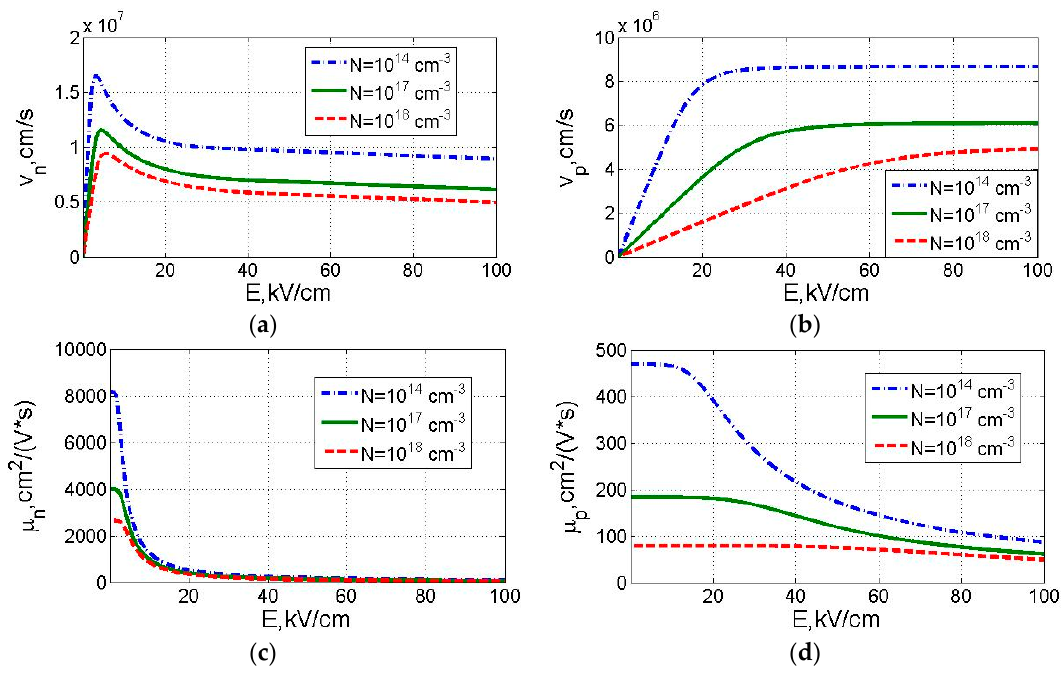
Figure 2. The dependences of average electron ( a ) and hole drift velocities ( b ) an the electron ( c ) and hole mobilities ( d ) on the electric field intensity in GaAs. The curves are calculated at different impurity concentrations applying Models (20)–(26) and the experimental data given in the paper [38].